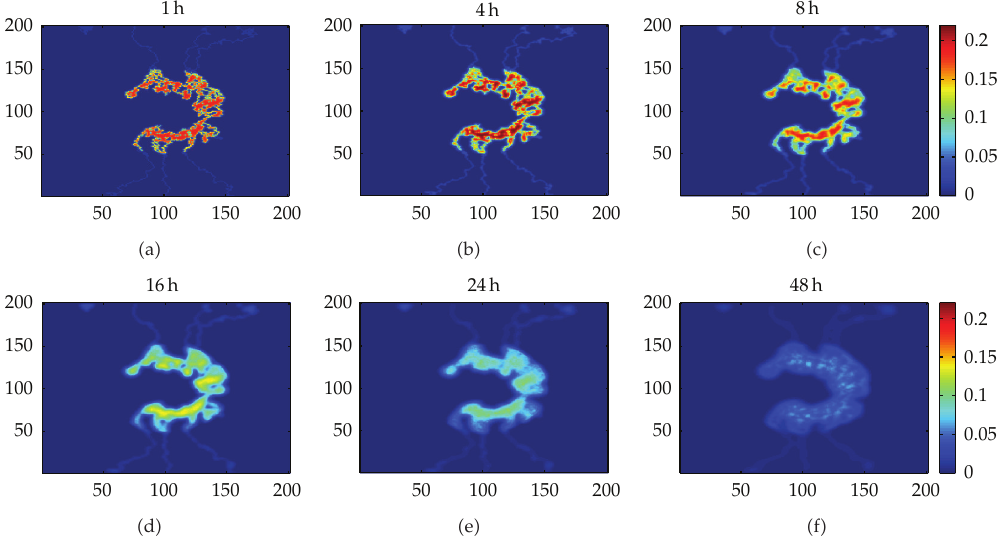
Figure 4: The simulation result of drug concentration before